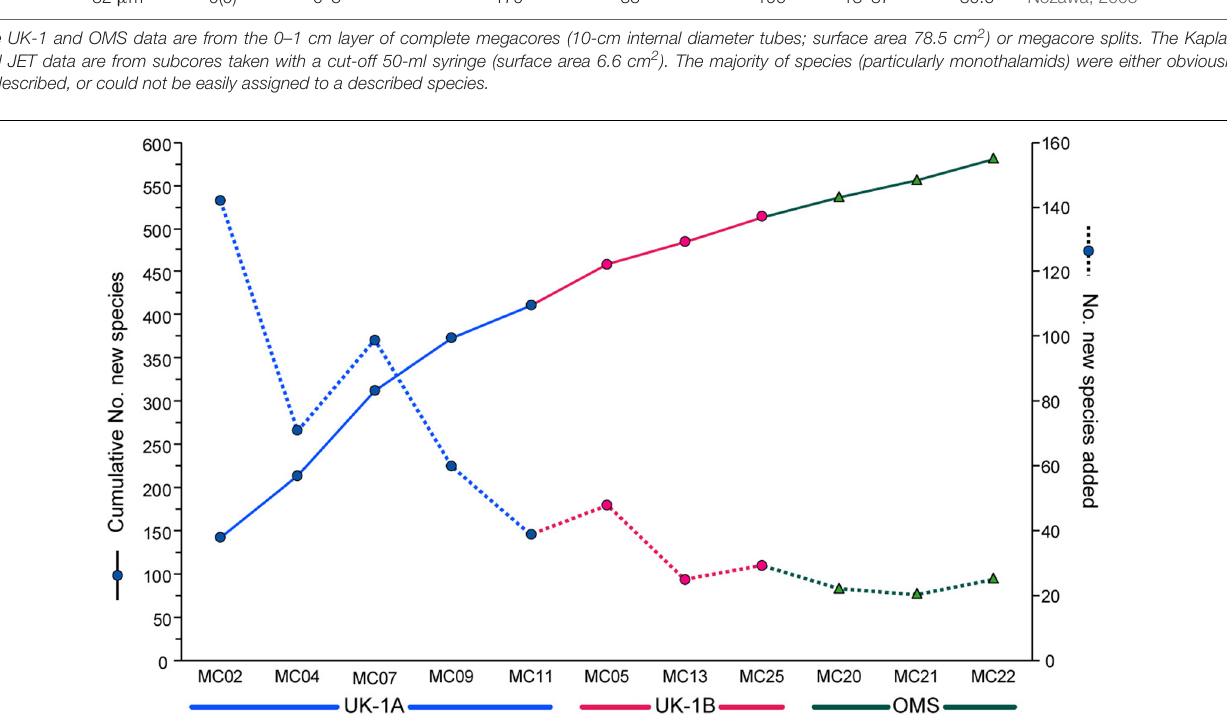
FIGURE 3 | Species accumulation curve (solid line; left-hand axis) showing the increase in the number of species with the addition of new samples from Strata A and B in the UK-1 contract area and the single Stratum in the OMS area (the ‘strata’ are 30 × 30 km study areas). The dotted line shows the number of new species added with each new sample (right-hand axis). Redrawn from Deep-Sea Research I, vol. 149, A. Goineau and A.J. Gooday, Diversity and spatial patterns of foraminiferal assemblages in the eastern Clarion–Clipperton zone (abyssal eastern equatorial Pacific), Article 103036, 2019, with permission from